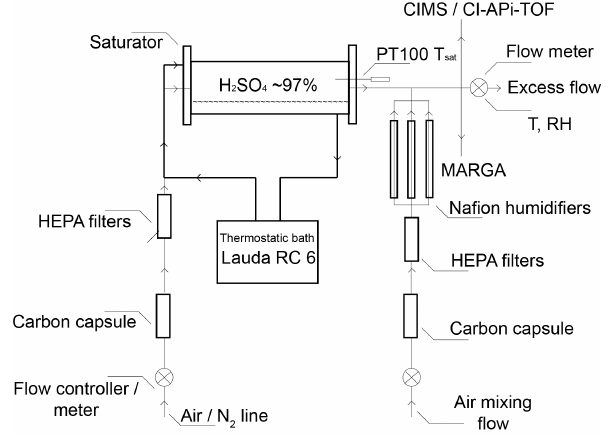
Figure 1. Schematic figure of the setup for testing the